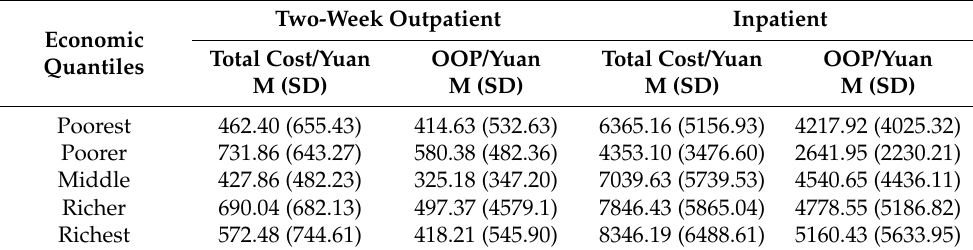
Table 6. Health service costs probability in different economic quintiles in China.